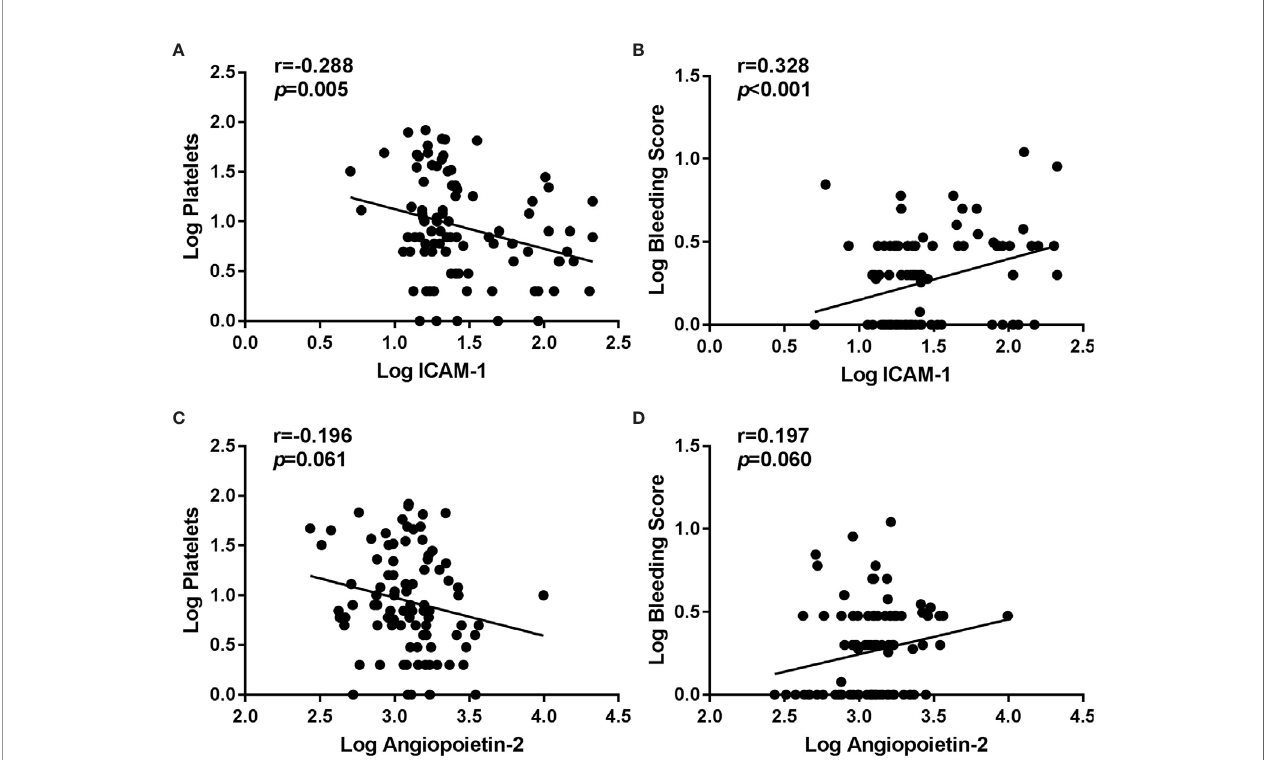
FIGURE 2 | Correlation between initial plasma Angiopoietin-2/ICAM-1 and clinical variables in 88 corticosteroid resistant ITP patients. By Pearson ’ s correlation coef fi cient analyses, we found negative correlation between ICAM-1 and platelet count (A) , but no obvious association between Angiopoietin-2 and platelet count (C) . Meanwhile, we found positive correlation between ICAM-1 and bleeding score (B) , but no signi fi cant association between Angiopoietin-2 and bleeding score (D) . All variables are log transformed.